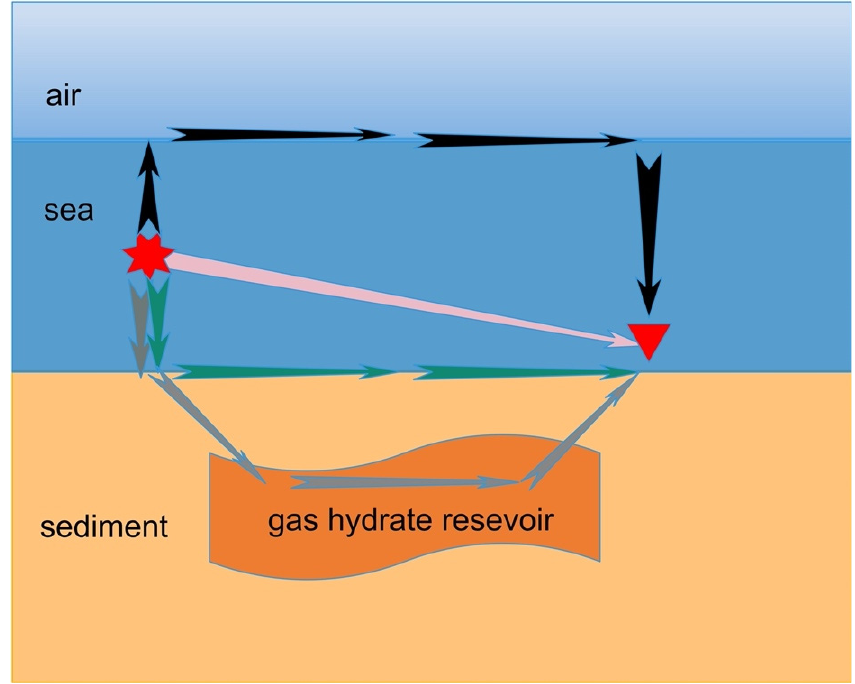
Figure 2. An illustration of diffusive electromagnetic field paths through the model for the given configuration. The gas hydrate reservoir is embedded in the sediments. The red star and triangle represent the source and the receiver, respectively. The arrows indicate the main propagation paths of EM field: direct field (pink), direct airwave contribution (black), direct ground wave (green), and the direct contribution from the reservoir (grey).